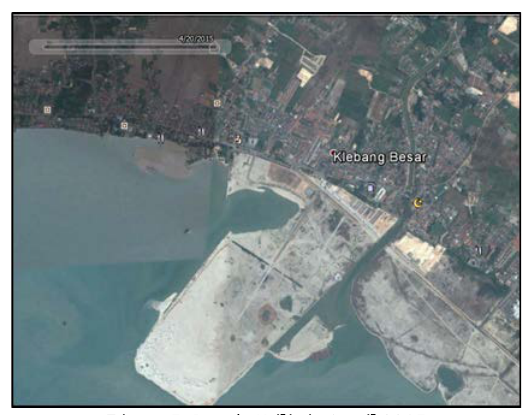
Figure 5. Banda Hilir in April 2015